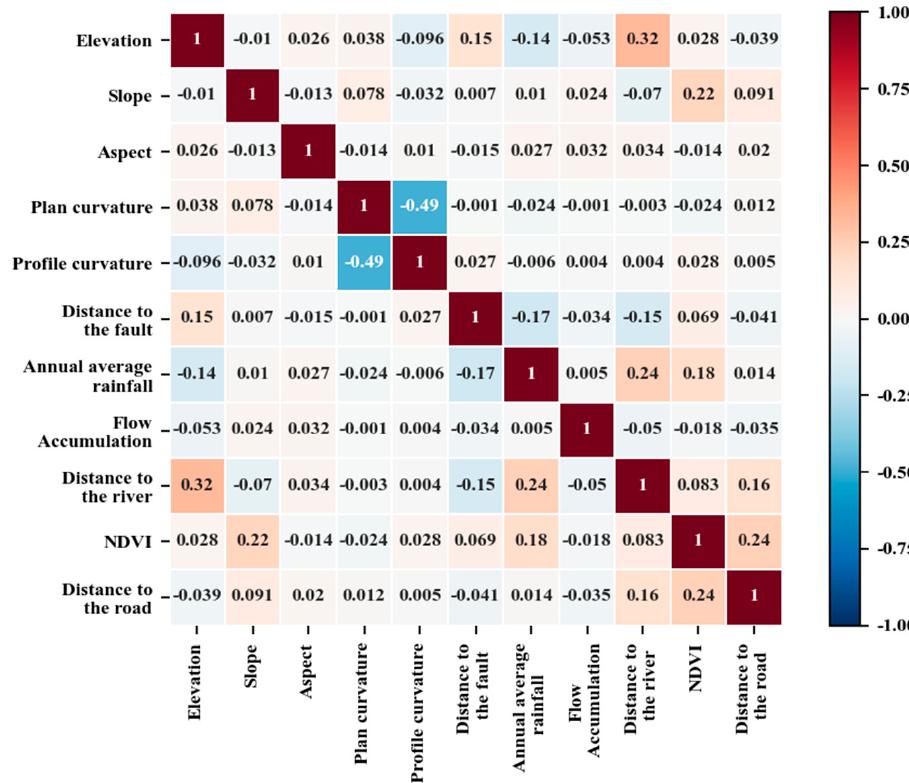
Figure 7. Pearson correlation coefficient matrix of affecting factors. Table 2. Multicollinearity results of affecting factors.